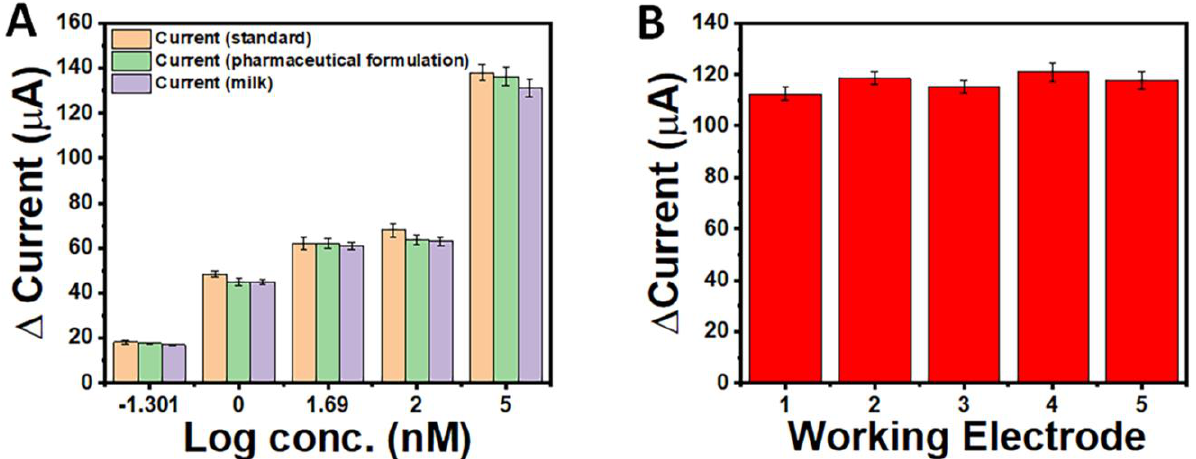
Figure 10. ( A ) Real sample assay depicting a higher percentage recovery of CFX in the pharmaceutical formulations and milk sample in the range of 0.05–10 5 nm; ( B ) Histogram showing the chip-to-chip reproducibility of the three-dimensional nanoimprinted dendritic surface.